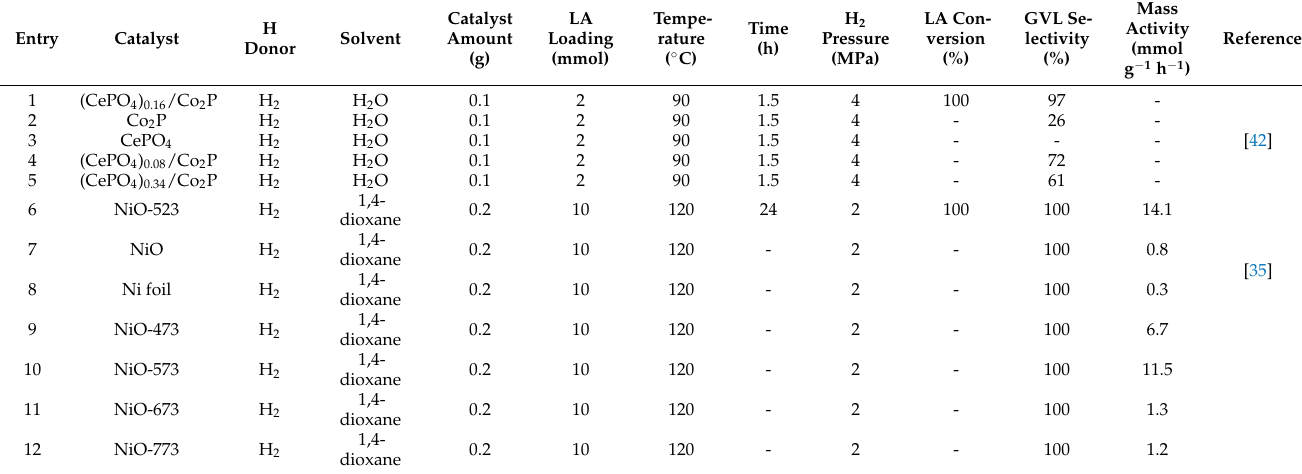
Table 4. Heterostructural catalysts for the hydrogenation of LA to